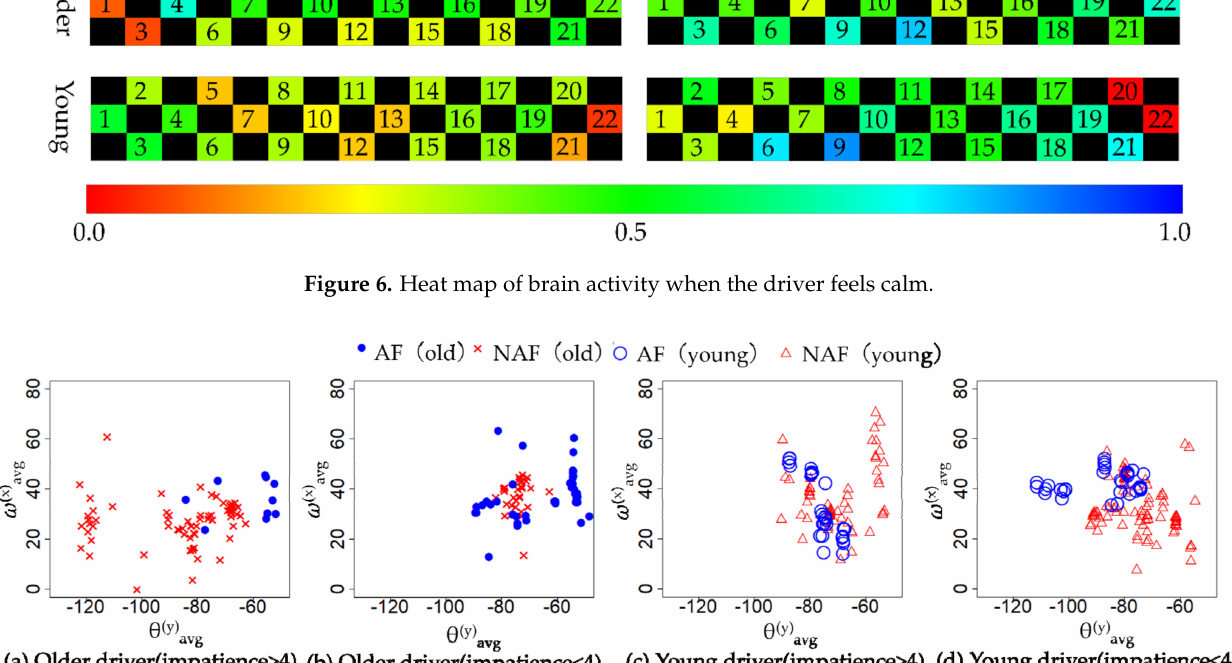
Figure 7. The y − axis tilt angle and angular velocity in the x − axis when the driver feels impatient or